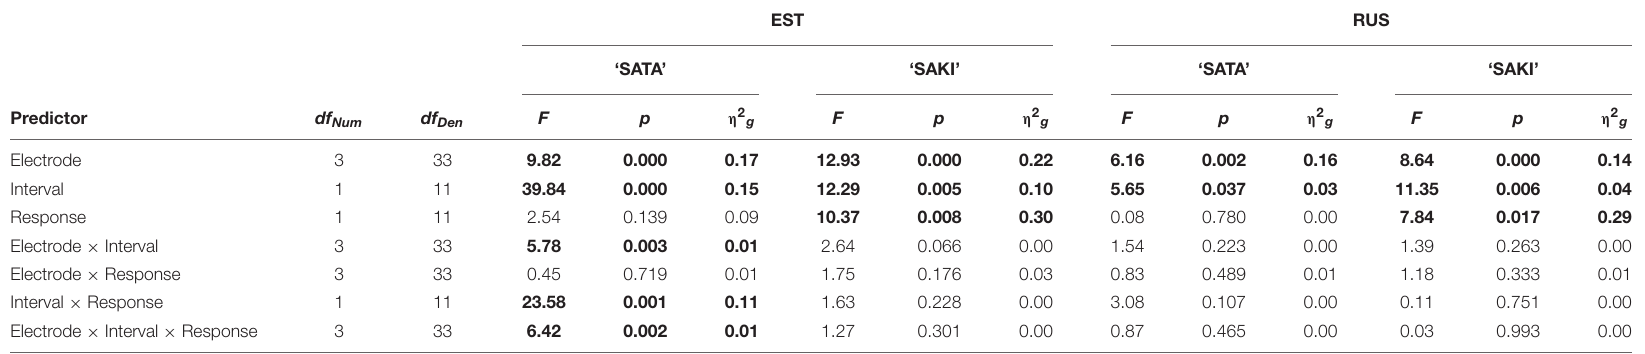
EST RUS ‘SATA’ ‘SAKI’ ‘SATA’ ‘SAKI’